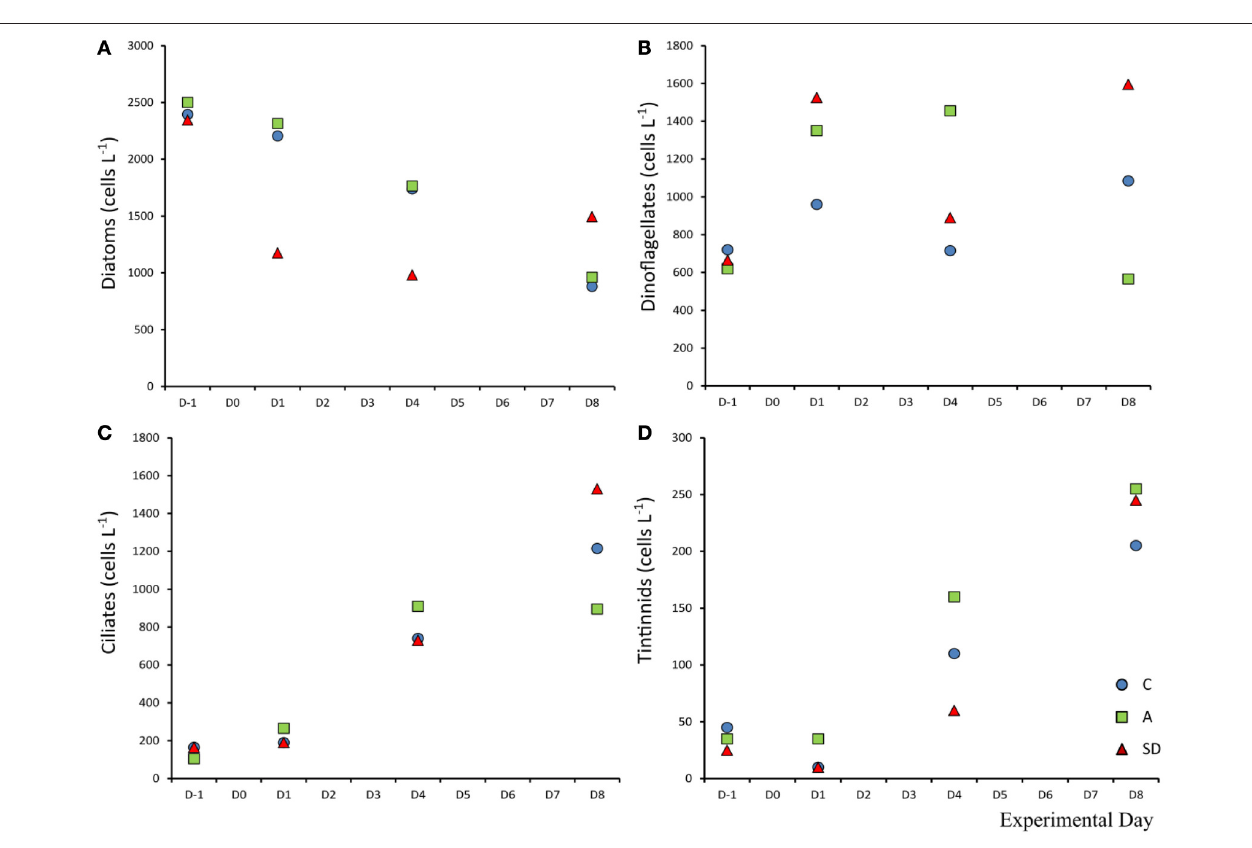
at D1 (1,525 cells L − 1 ) in the SD treatment. Initial average ciliate abundance (D-1) was 145 cells L − 1 , the abundance increased in all mesocosms and was highest in the SD treatment. On Day 8, in the SD mesocosms, ciliate abundance was almost 10 times higher than the start, at 1,530 cells L − 1 , which was also the highest abundance measured. Loricate tintinnids also increased, from an initial abundance of 35 cells L − 1 to a final abundance of 1,213 cells L − 1 in the A treatment ( Figures 11A–D